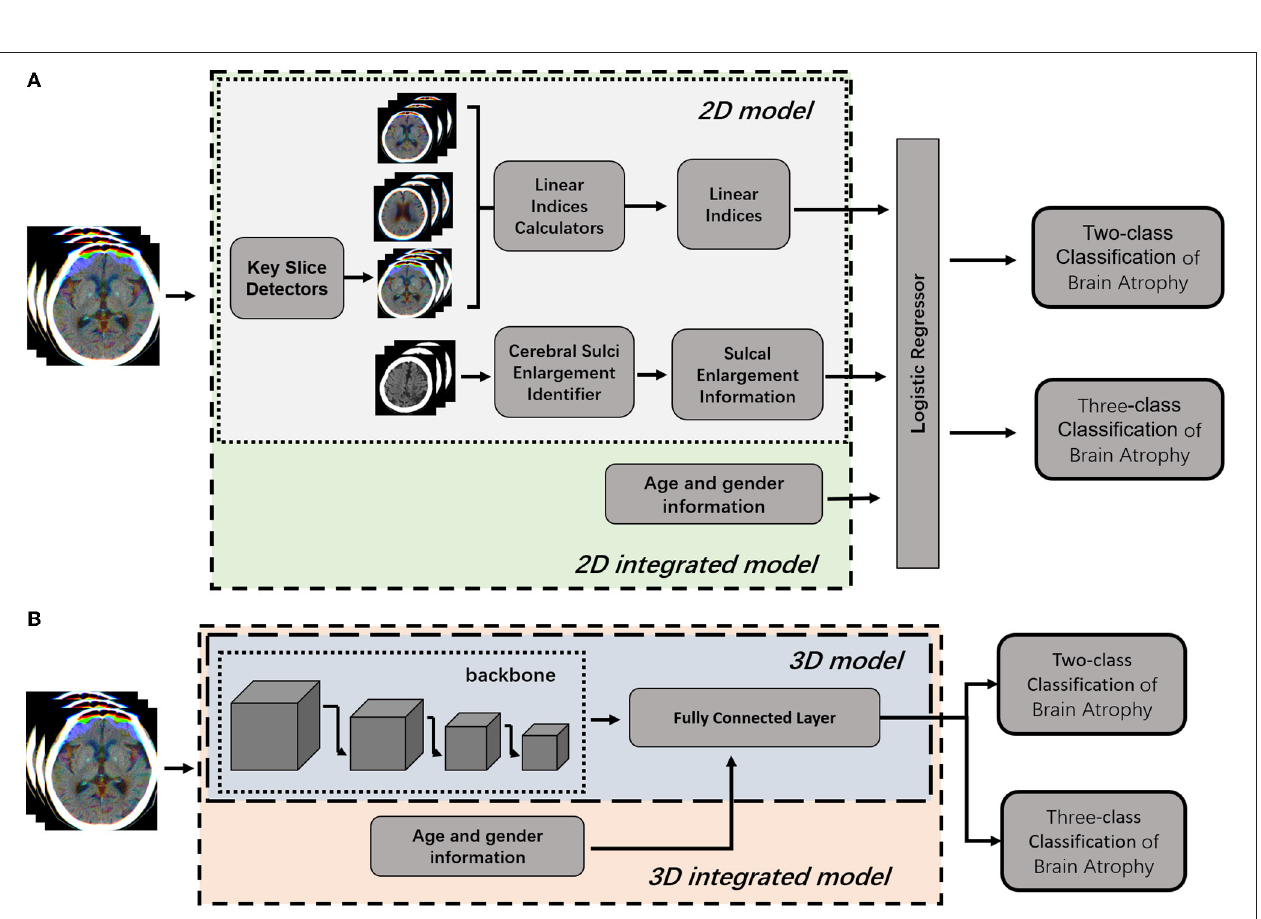
FIGURE 3 | Illustration of 2D model and 3D model for brain atrophy classification. (A) 2D model was consisted of four modules, such as key slice detectors, linear measurements calculators, cerebral sulci enlargement identifier, and atrophy classifier. Information of age and gender were integrated into the atrophy classifier of 2D model to generate 2D-integrated model. (B) 3D model was developed based on a 3D CNN model. Information of age and gender were integrated into the full connected layer to generate the 3D-integrated model.